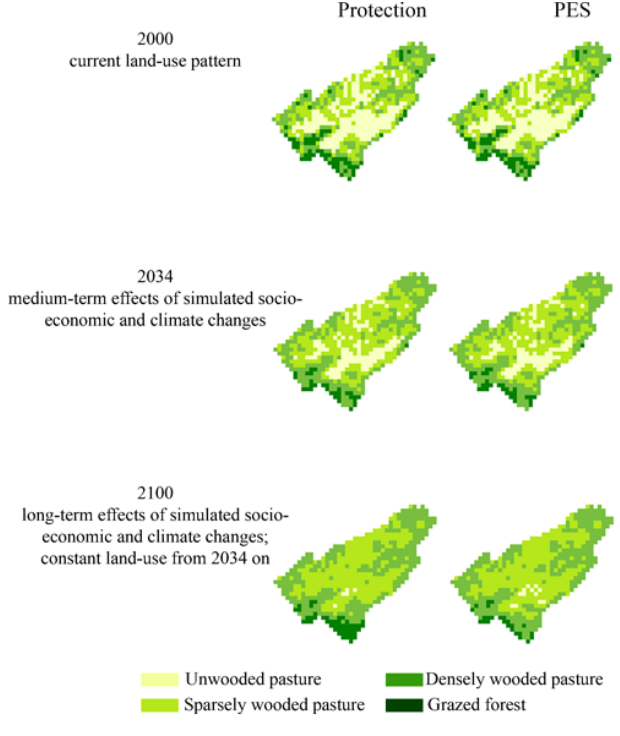
Fig. 3 . Landscape: structural change in La Bullatonne (1300 m a.s.l, extensive use) with the protection and payment for environmental services (PES) policy